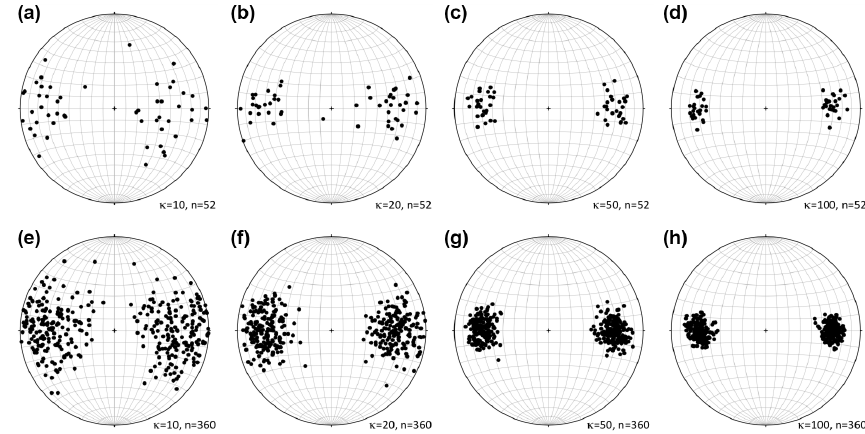
Figure 3. Stereographic projections (equal area, lower hemisphere) showing the eight synthetic datasets designed to model conjugate (bi- modal) fault patterns in this study. (a–d) Synthetic fault datasets derived from equal mixtures of two Watson distributions with mean pole directions separated by an inter-fault dip angle of 60 ◦ . These models represent a “low fault count” scenario, with n = 52 and κ (the Watson dispersion parameter) varying from 10 to 100. (e–h) These models represent a “high fault count” scenario, with n = 360 and κ varying from 10 to 100.